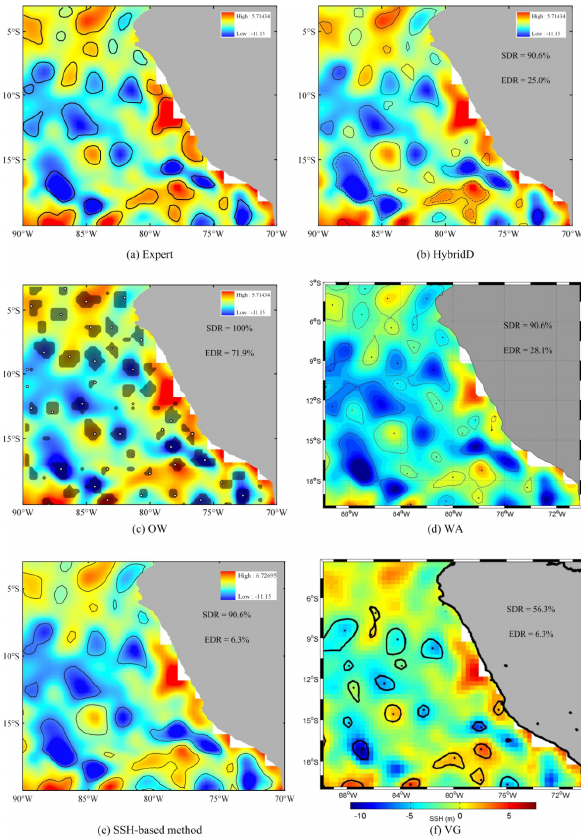
Figure 8. Results of manual detection and automatic algorithms. The boundaries are delineated by black solid lines. Grey dark polygons in the OW detection denote where W parameter satisfies the criterion, and the white dots represent the SLA local extrema. The detection result of WA method is provided by A. Chaigneau. The SSH-based method result is generated according to the criteria in Chelton et al. (2011). The VG result is derived by the MATLAB code provided by F. Nencioli. The results in these subgraphs are superposed on SLA field of 8 December